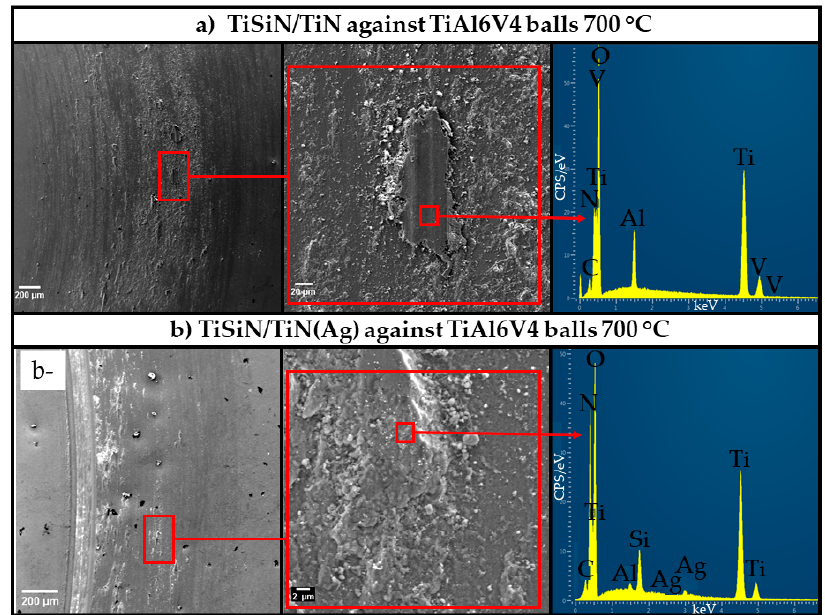
Figure 8. SEM micrographs of the wear tracks of the ( a ) reference and ( b ) Ag-doped coatings, tested at 700 °C against TiAl6V4 balls. The EDS spectrum of wear debris detected in the wear track of the coatings is plotted too.